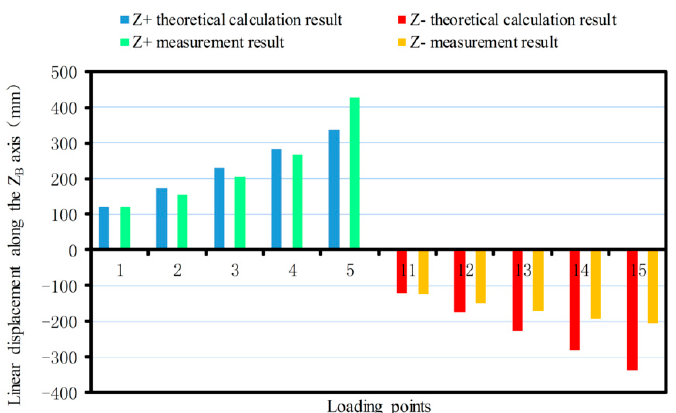
Z -axis. B Z -axis. Z -axis. B B